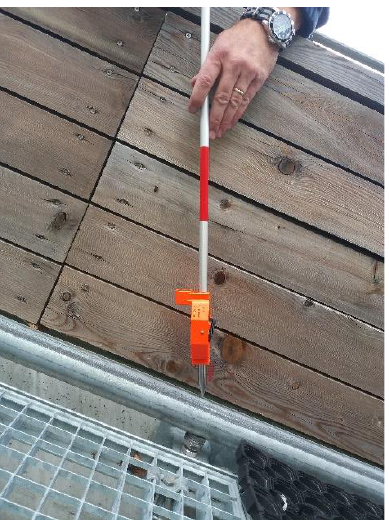
Figure 3. Measurement with the Leica GMP111-0 mini prism.